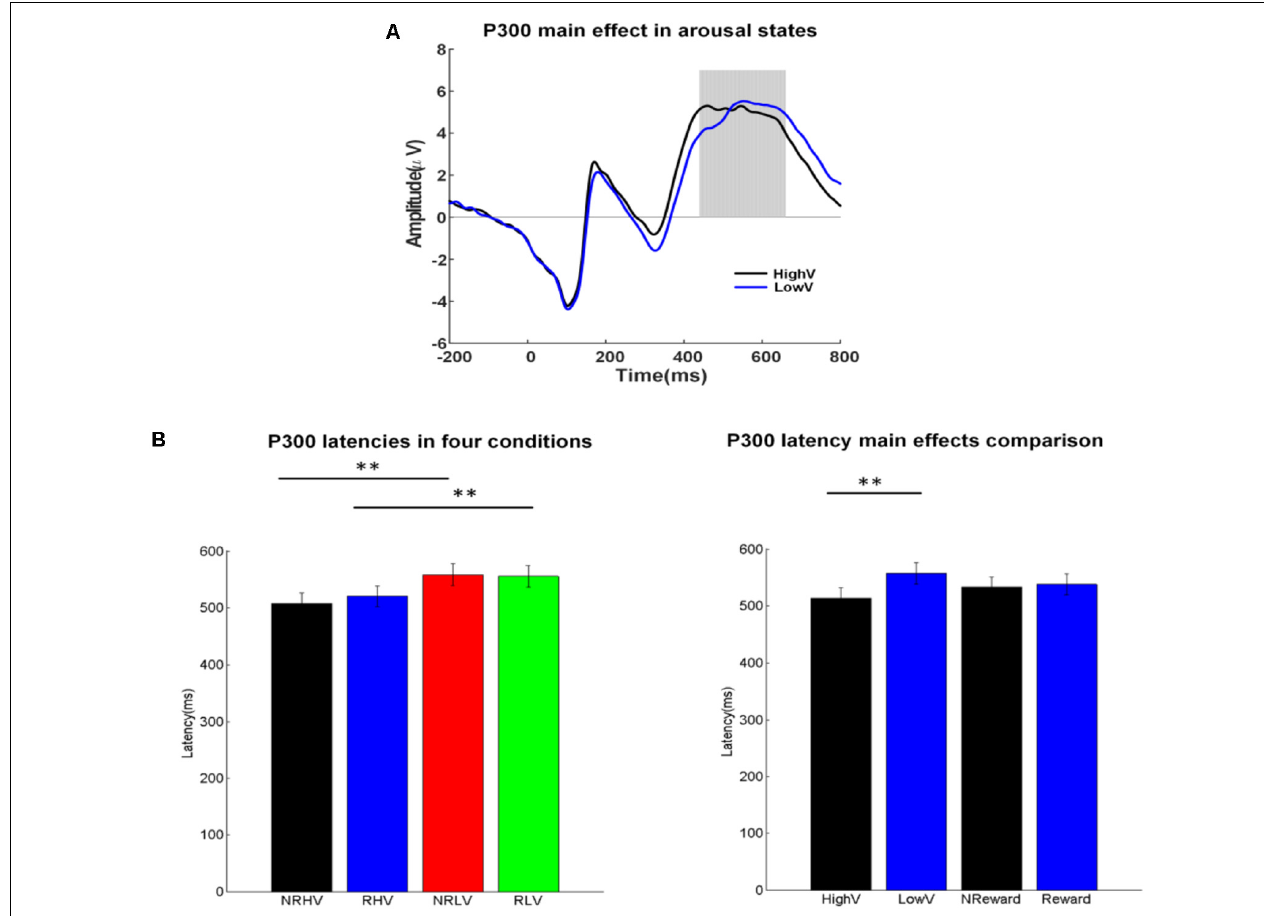
FIGURE 4 | (A) P300 waveforms coalesced for the high vs. low vigilance states. (B) Mean values and standard error for the P300 latency in the four conditions (left) and for the two main factors (right). The ANOVA results were marked by ∗ p < 0.05 and ∗∗ p < 0.01.